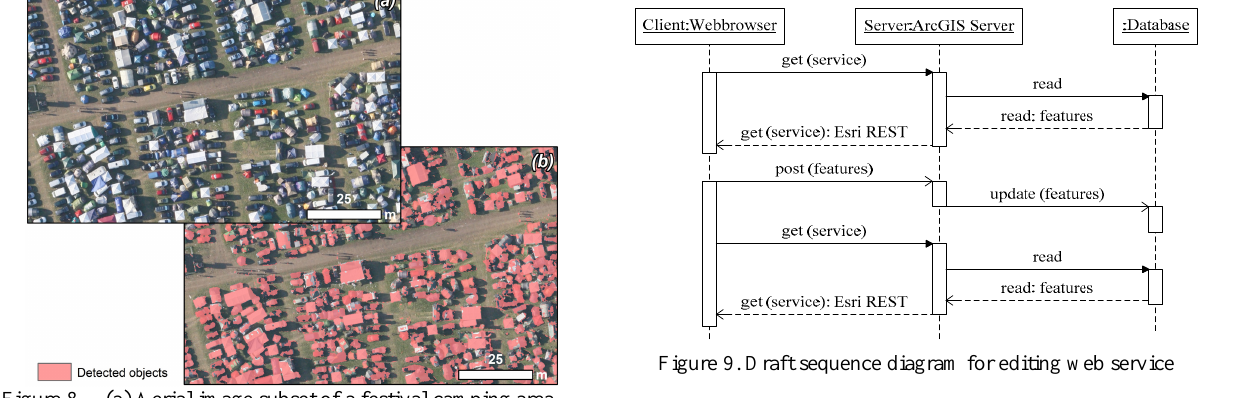
Figure 8. (a) Aerial image subset of a festival camping area, (b) classification of tents and vehicles (red)